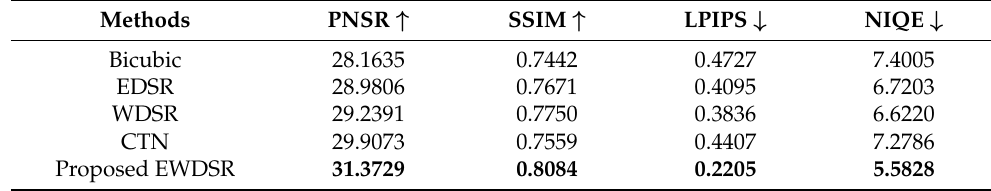
Table 1. Quantitative performance of different super-resolution methods. The best values are in